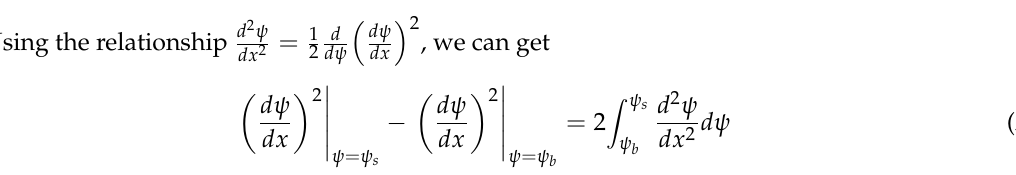
Figure 1. ( a ) Cross ‐ sectional view of indium zinc oxide thin ‐ film transistors (IZO TFTs) with inverted staggered bottom gate structure; ( b ) energy band diagram along the thin ‐ film depth direction of IZO TFTs.